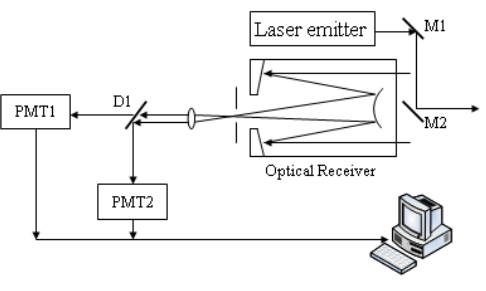
Figure 1. The block diagram of two-wavelength lidar